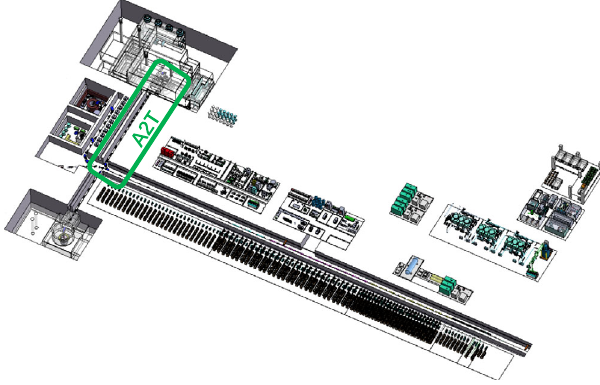
FIG. 1. The layout of the CiADS accelerator.